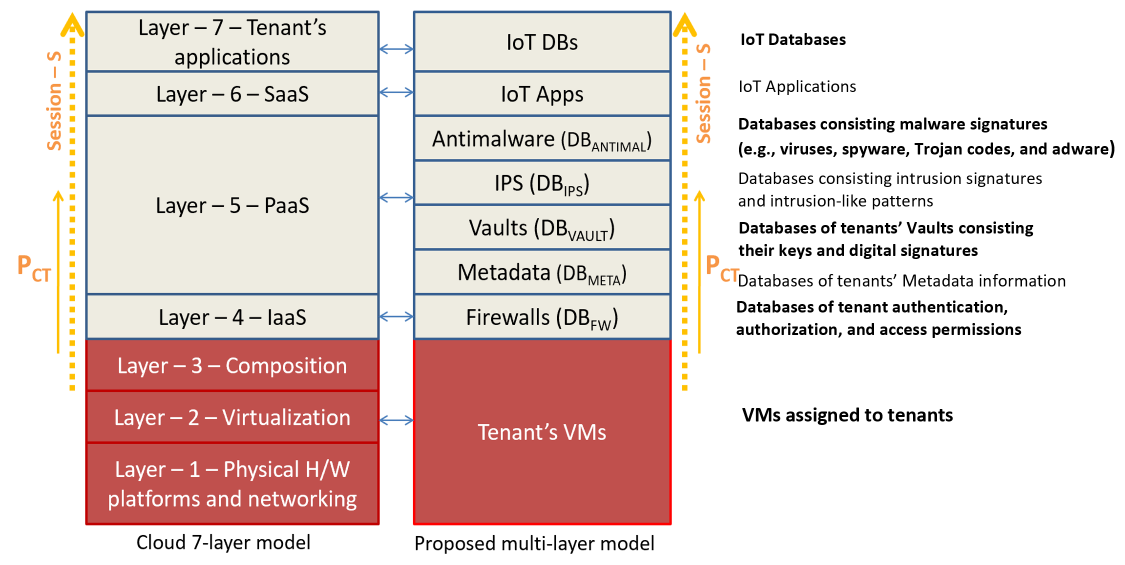
Figure 1. Multi-layer security proposed model